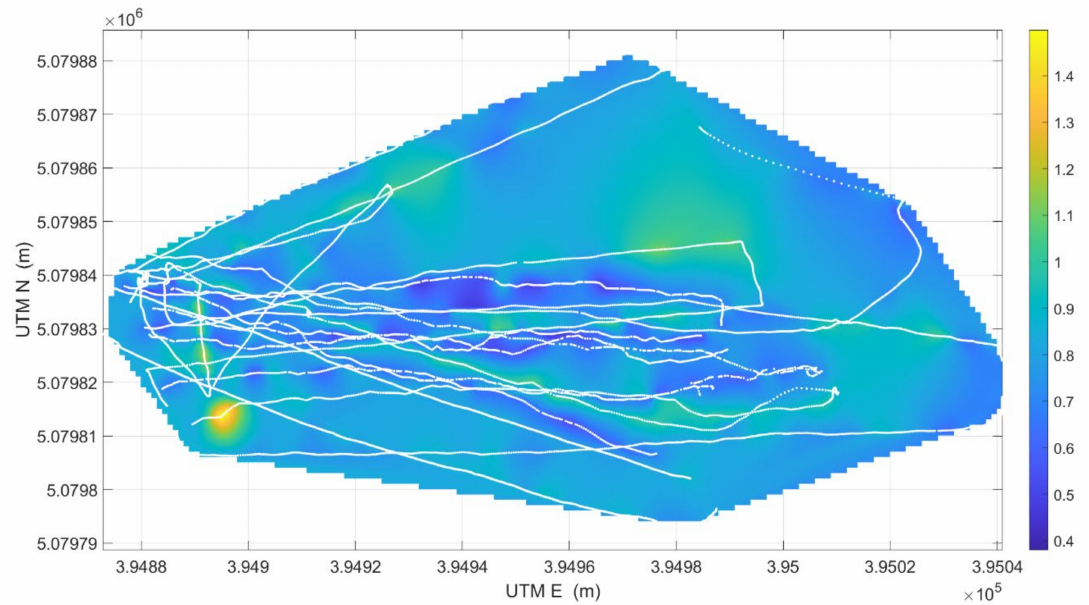
Figure 10. Snow depth distribution calculated from aerial survey data and ground-coupled survey data. Values in the colour scale are expressed in meters. Data are slightly smoothed for better